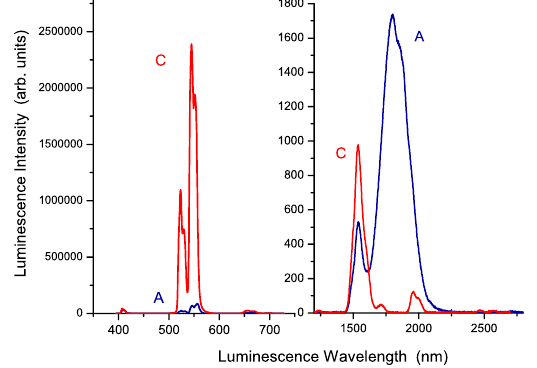
Figure 6. Visible and infrared luminescence spectra of samples (A) Er 3 + (8%)Tm 3 + (0.5%):telluride glass and (C) Er 3 + (0.5%):telluride glass when excited by 380 nm light for the 4 I 15/2 → 4 G 11/2 absorption of Er 3 +